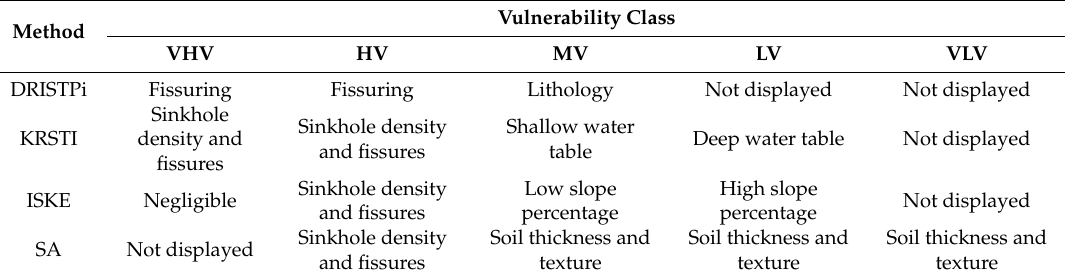
Figure 5. Percentage comparison of vulnerability classes displayed in Yucatan from four vulnerability methods. Table 7. Important parameters leading specific vulnerability classes derived from spatial match with final